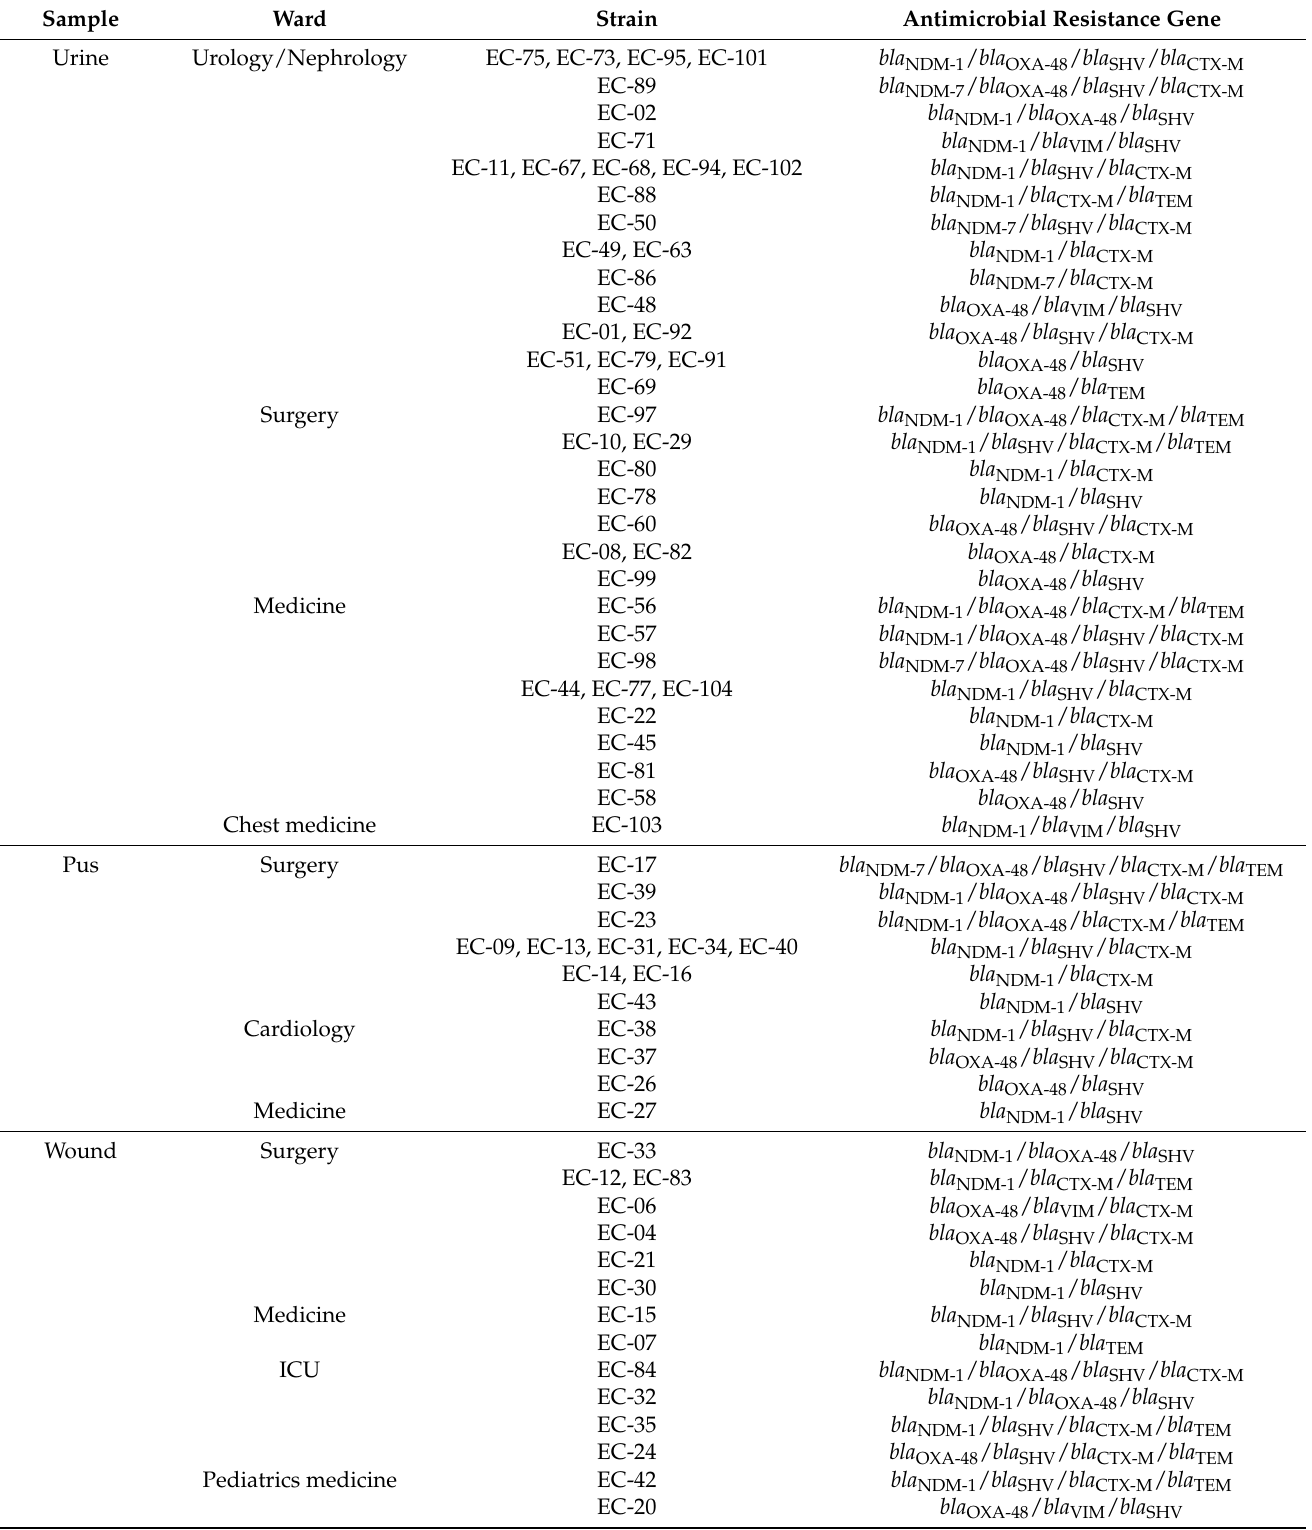
Table 1. Molecular profile of carbapenem-resistant E. coli